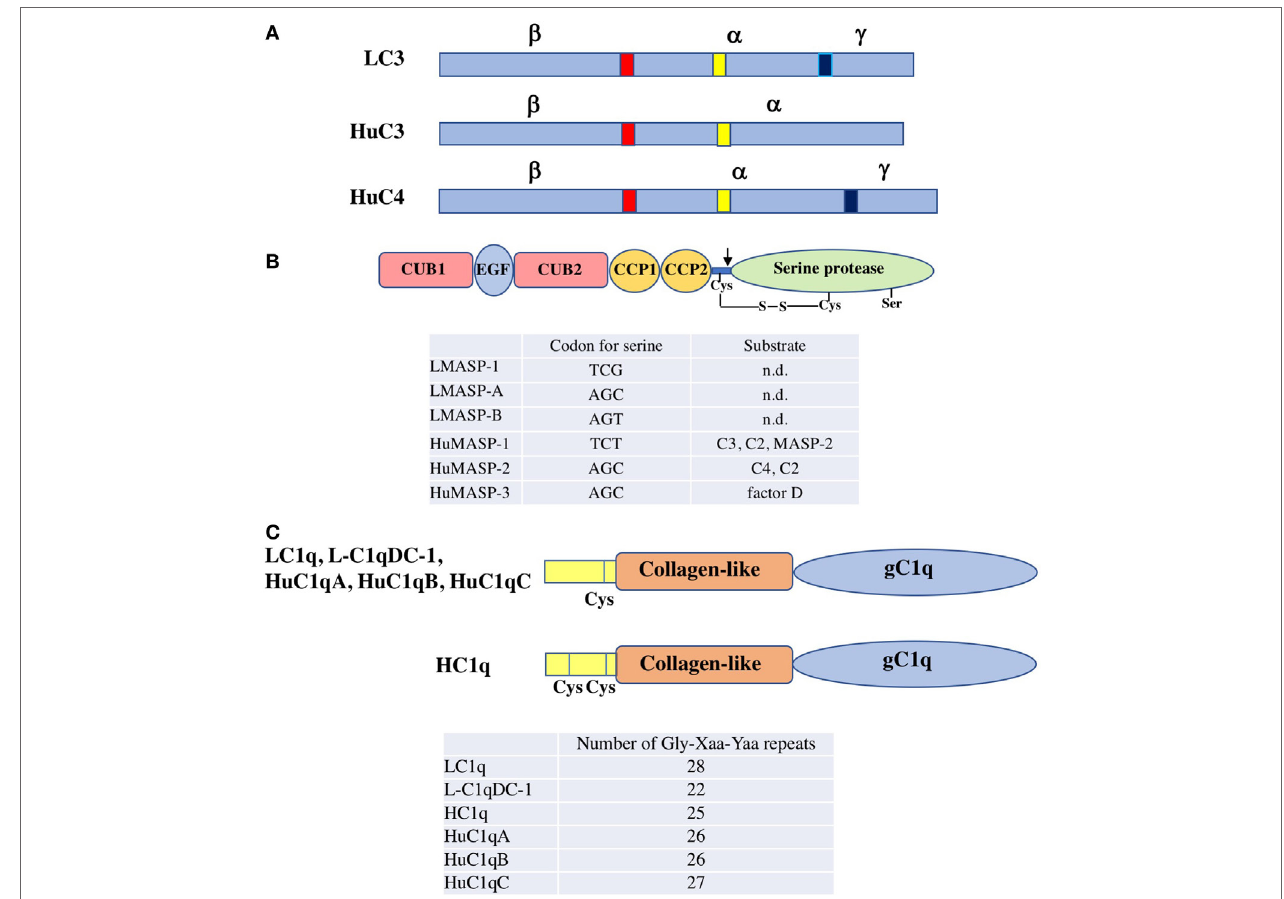
FiguRe 2 | Structure of agnathan complement components. (A) Schematic representation of the primary structure of lamprey C3 (LC3), human C3 (HuC3), and human C4 (HuC4). The β − α and α − γ processing sites are shown in red and blue, respectively. These proteins are produced as a single polypeptide. After processing, the mature proteins with disulfide-bridged three polypeptides ( α , β , and γ chains) or with disulfide-bridged two polypeptides ( α and β chains) are produced. The thioester region is shown in yellow. (B) Domain structure of lamprey and human MASP. MASP consists of six domains, C1r/C1s/Uegf/bone morphogenetic protein (CUB) 1, epidermal growth factor, CUB 2, complement control protein (CCP) 1, CCP2 and serine protease domain. An unactivated form of MASP with a single polypeptide chain changes to an active form of MASP with two polypeptide chains linked by a disulfide bond by cleavage of a peptide bond (arrow). Codon for the serine residue essential for the catalytic activity in the protease domain of each MASP is listed. Substrates for each MASP are also summarized (n.d, not determined). LMASP-1, lamprey MASP-1; LMASP-A, lamprey MASP-A; LMASP-B, lamprey MASP-B; HuMASP-1, human MASP-1; HMASP-2, human MASP-2; HMASP-3, human MASP-3. (C) Domain structure of lamprey and human C1q. C1q consists of both collagen-like and gC1q domains. The number of Gly-Xaa-Yaa repeats of each C1q is listed. One cysteine residue is present in the N-terminal region for LC1q, L-C1qDC-1, HuC1qA, HuC1qB, and HuC1qC, while two cysteine residues for HC1q. HuC1qA, human C1qA chain; HuC1qB, human C1qB chain; HuC1qC, human C1qC chain.